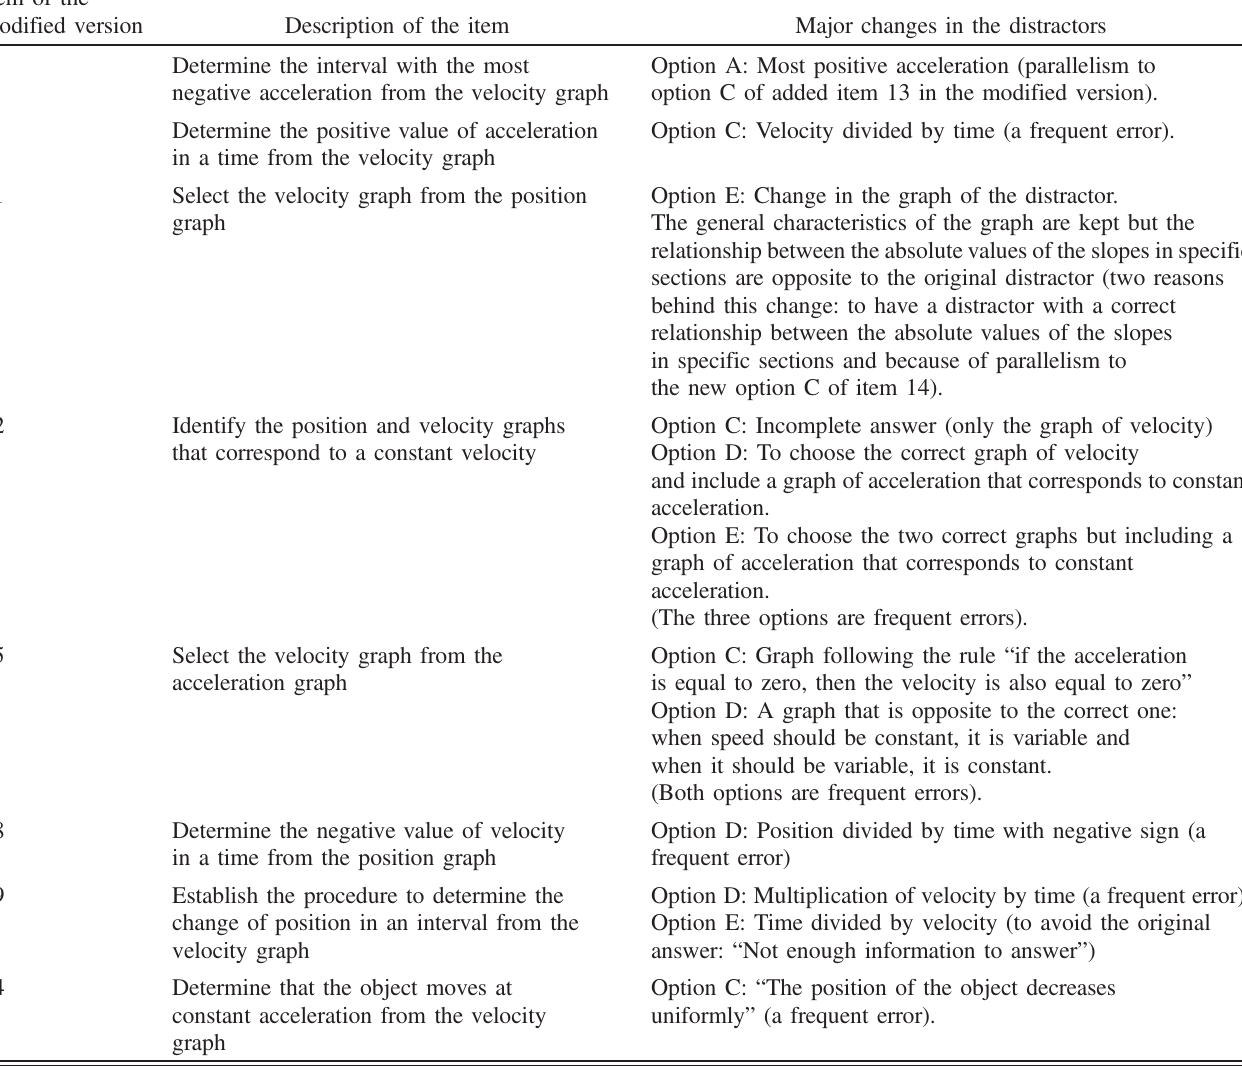
TABLE X. Difficulty index ( P ), discriminatory index ( D ), and point-biserial coefficient ( r